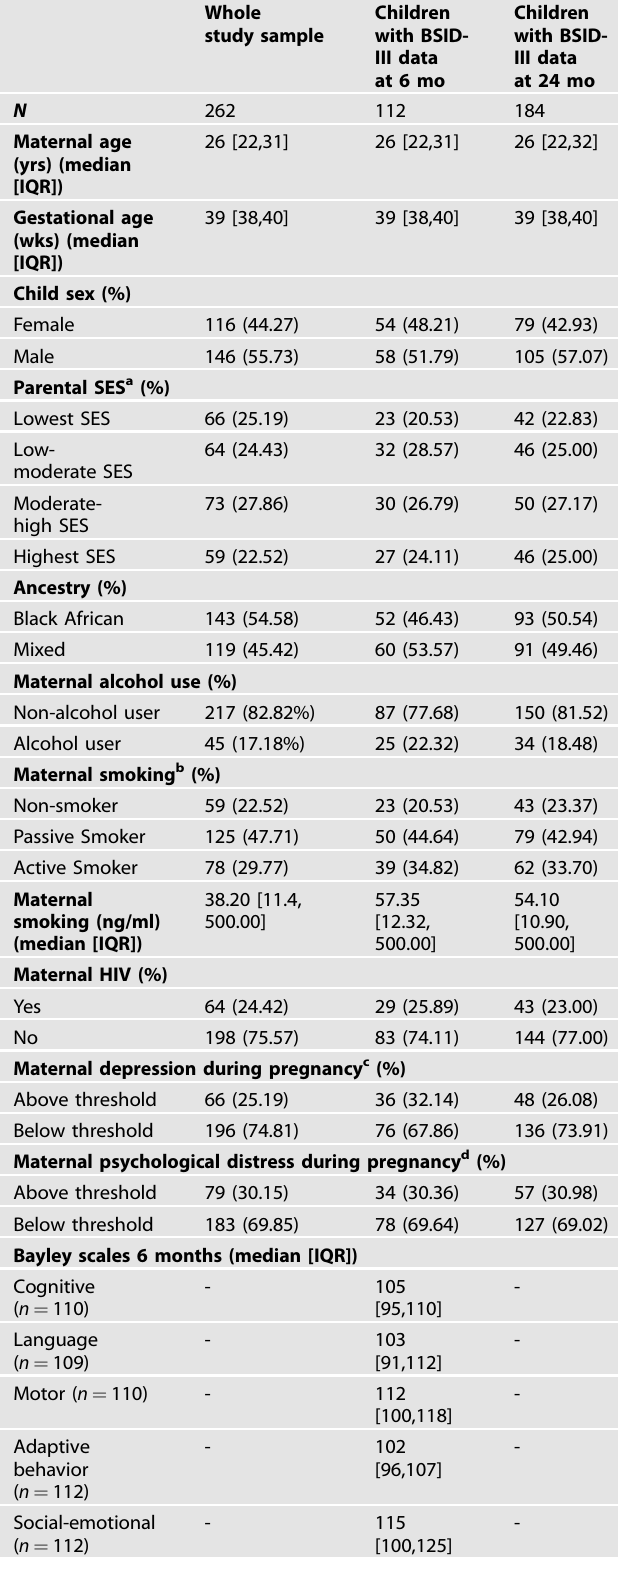
Table 1. Study population characteristics for the whole sample, children with BSID-III measurements at 6 months of age, and children with BSID-III measurements at 24 months of age. Whole Children study sample with BSID-